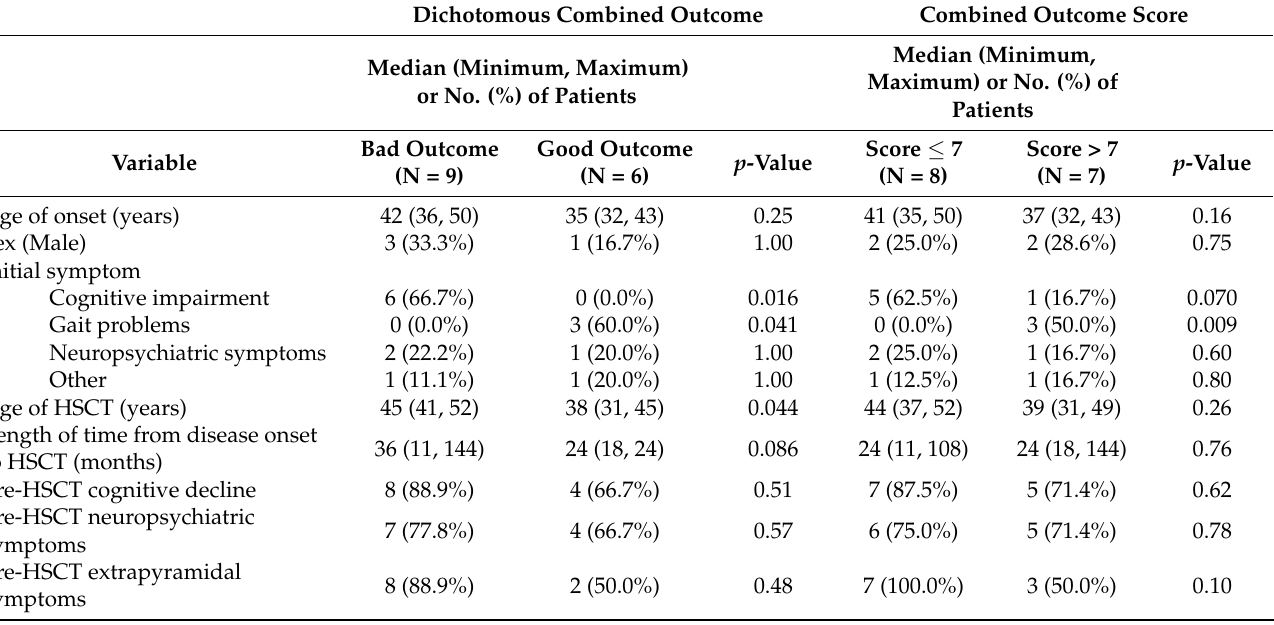
Table 6. Associations of patient characteristics with post-HSCT combined outcome